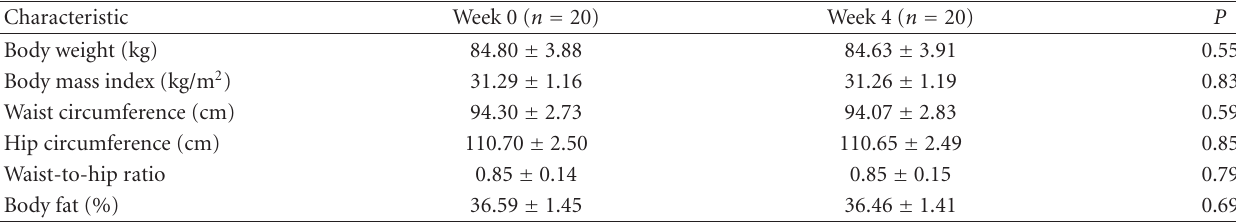
Table 2: Anthropometric parameters and percentage of body fat at baseline (week 0) and at the end of the study (week 4). Characteristic